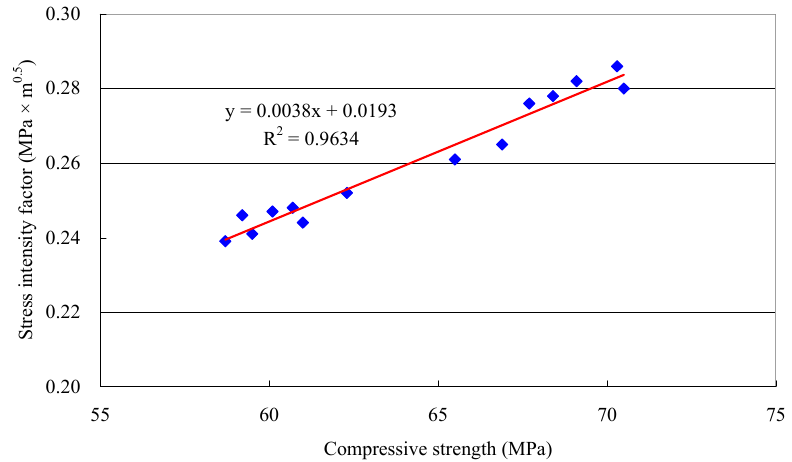
Figure 8. Critical stress intensity factor versus compressive strength for slag concretes.